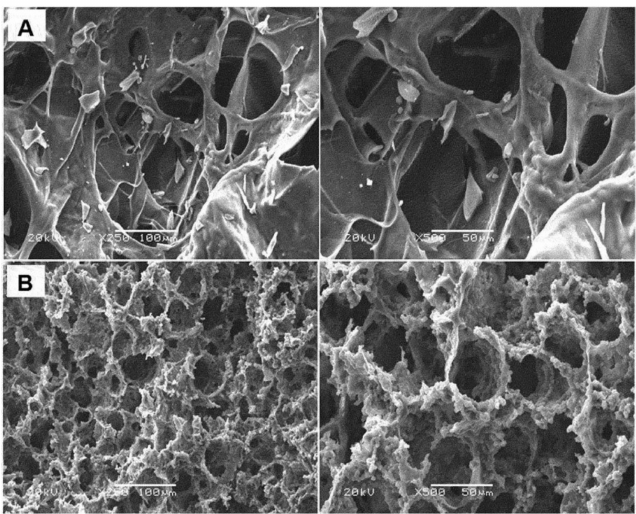
Figure 4. Scanning electron microscopy images of bare poly(2-hydroxyethyl methacrylate) ( A ) and embedded composite ( B ) cryogels. Republished with permission from [48]. Copyright 2014 Taylor & Francis.